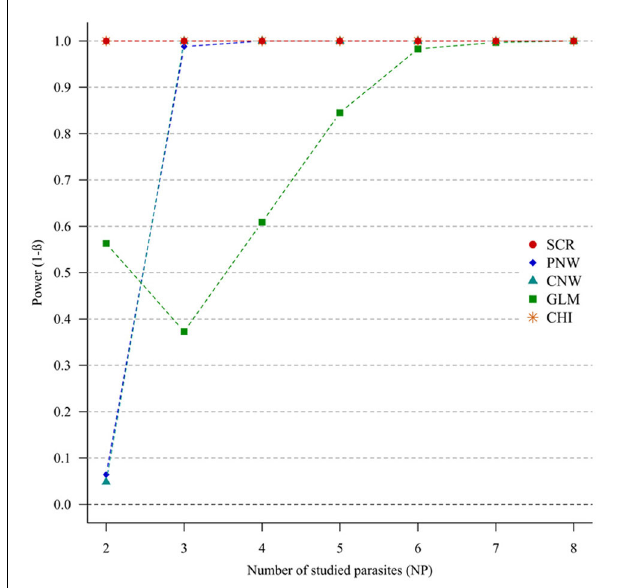
FIGURE 3 | Simulation outputs relative to the test of power (1- β ) for the four approaches used to detect parasite structuring, with weak positive correlations. CHI, generalized chi-square test; PNW, parasite network model; CNW, combination network model; GLM, multinomial GLM model and SCR, the association screening approach. The number of parasites varied from two to eight and the size of the total host population was fixed to 1000.